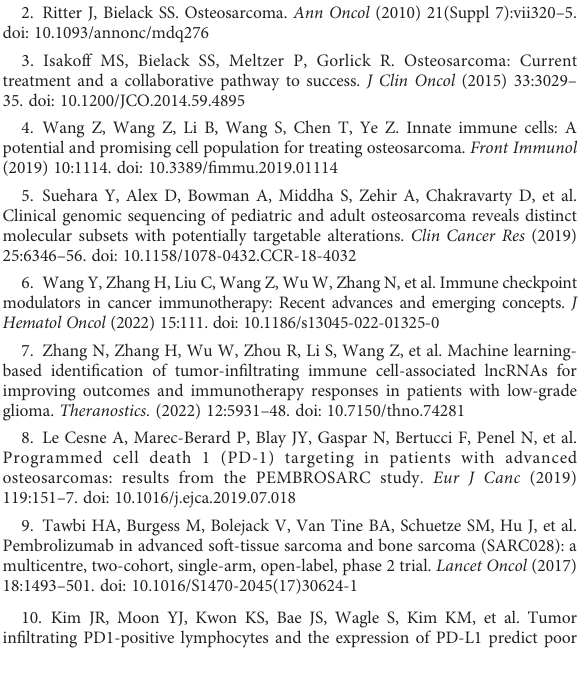
genes in cluster one and cluster two. The length of bars represents gene counts of GO terms. Color represents adjusted p value (Benjamini- Hochberg), the redder the color, the greater the signi fi cance. SUPPLEMENTARY FIGURE 3 Kaplan – Meier survival analysis for TARGET OS patients based on the expression of ATF4 (A) , HILPDA (B) , ATM (C) , CBS (D) , MUC1 (E) , MT1G (F) , PML (G) , ARNTL (H) . SUPPLEMENTARY FIGURE 4 Validation of the ferroptosis prognostic signature in GEO OS cohort. (A) Distribution plots ofrisk scores andheatmap of signaturegene expression in GEO OS patients. Red represents high expression level and blue represents low expression. The darker the color, the greater the signi fi cance. (B) Kaplan-Meier analysis exhibiting the overall survival of GEO OS patients in high-risk group and low-risk group. (C) Time dependent ROC curve analysis of the ferroptosis signature model in predicting prognosis of GEO OS patients. * P < 0.05; ** P < 0.01; *** P < 0.001; **** P < 0.0001. SUPPLEMENTARY FIGURE 5 Single cell sequencing analysis of primary OS samples. (A) UMAP visualized 16 cell subclusters identi fi ed using “ FindClusters ” function. (B) Heatmap of top10 feature genes in 16 subclusters. Yellow represents high expression level of genes, purple represents low expression. (C) Expression of eight risk signature genes in all identi fi ed cells. Purple represents high expression of signature genes. The more purple the color, the higher the expression. (D) Expression proportion of eight signature genes among all detected cells in primary OS samples. Red represents the proportion of gene-positive cells and blue represents the proportion of gene-negative cells.